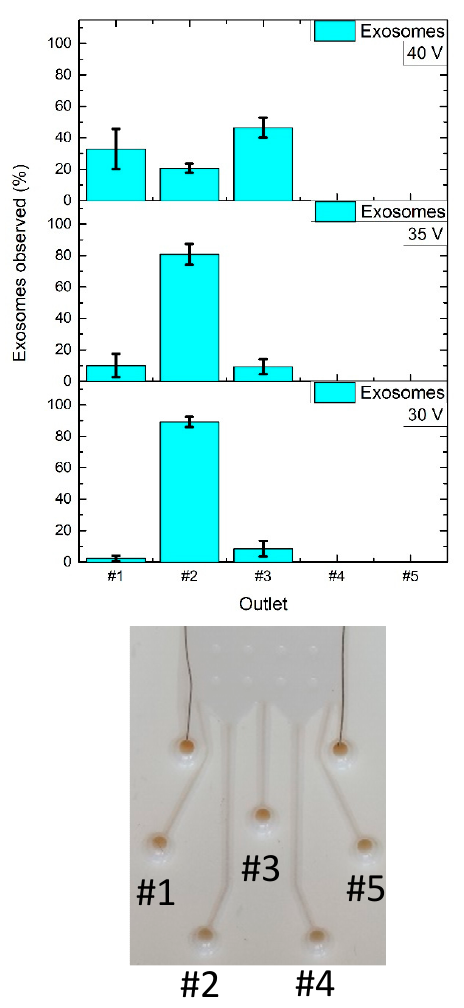
Figure 8. Exosome (EX) collections at the outlets of the glossy µFFE device by setting a buffer flow rate of 20 µL/min and an analyte flow rate of 10 µL/min for 10 min when Δ V = 30, 35 and 40 V were applied at the electrodes.